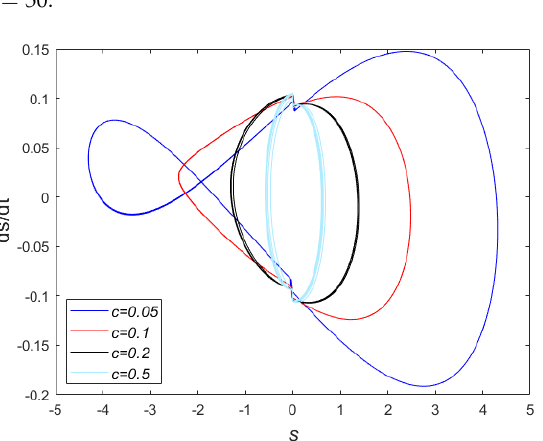
.  s for various amounts of c and considering p = 19, for various amounts of c and considering  for various amounts of c and considering